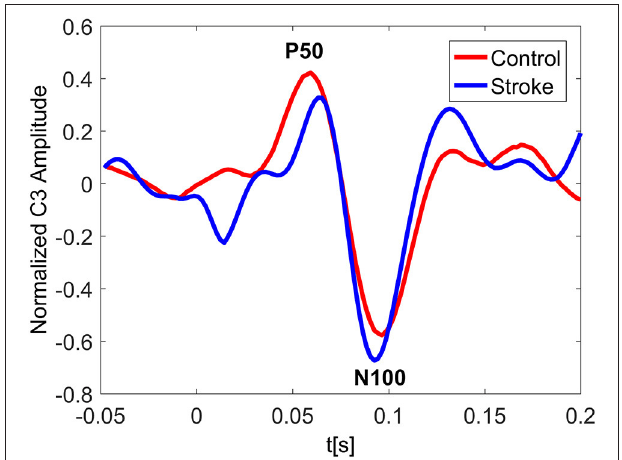
FIGURE 3 | Normalized ERP at the channel C3 for a control and a stroke subject with stimulus on right hand. The ERP plotting at C3 shows great similarity for both control and stroke. The latency of P50 peak for stroke is slightly larger than that of control.